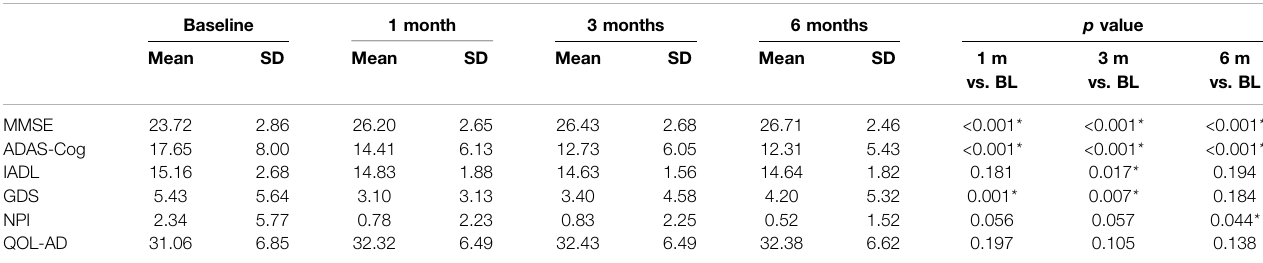
TABLE 3 | Intragroup outcome comparison in the GBE